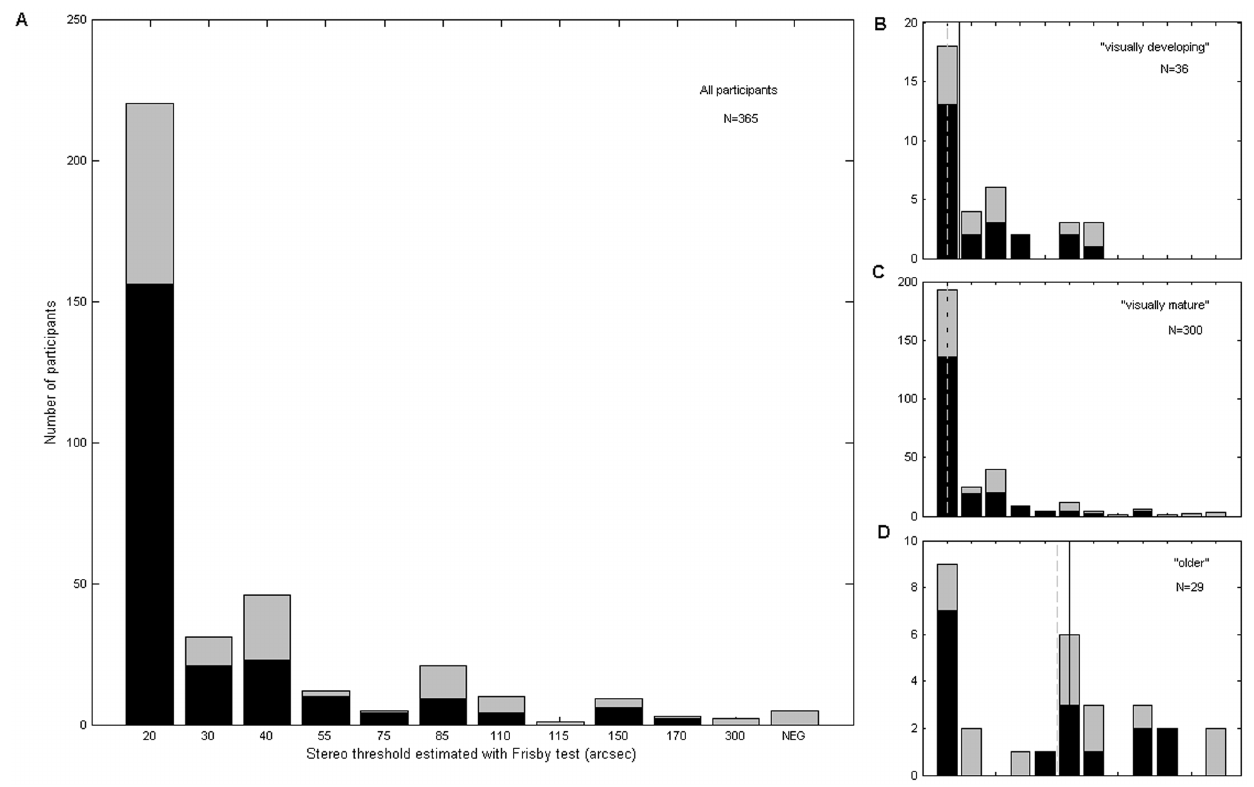
Figure 2. Frequency histogram of stereo thresholds estimated with the Frisby test. NEG = stereonegative; unable to perform test at largest available disparity. Main plot: all participants (dark bars = ‘‘no visual problem’’; light bars = ‘‘visual problem’’, as in Figure 1). Subplots: age subgroups on the same horizontal axis. Solid vertical line shows median for ‘‘no visual problem’’ subpopulation (dark bars); dashed vertical line shows median for whole group.